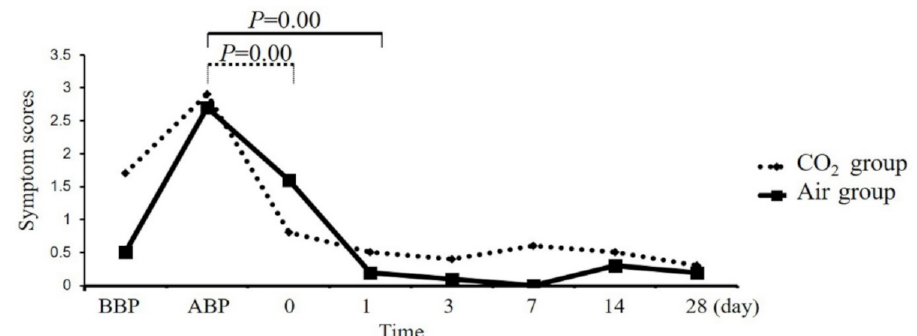
Figure 2. Changes in minor complications. Although there was no difference in minor complications between the CO 2 and air groups at each follow-up point (Table 2), the recovery of minor complications after colonoscopy was faster in the CO 2 group (2.9 ± 0.99 vs. 0.8 ± 1.48, p < 0.01) than in the air group (2.7 ± 0.68 vs. 1.6 ± 1.90, p = 0.10). CO 2 , carbon dioxide. BBP, before bowel preparation. ABP, after bowel preparation. 0, 1, 3, 7, 14, 28 indicates the day of the colonoscopy and 1, 3, 7, 14, 28 days after